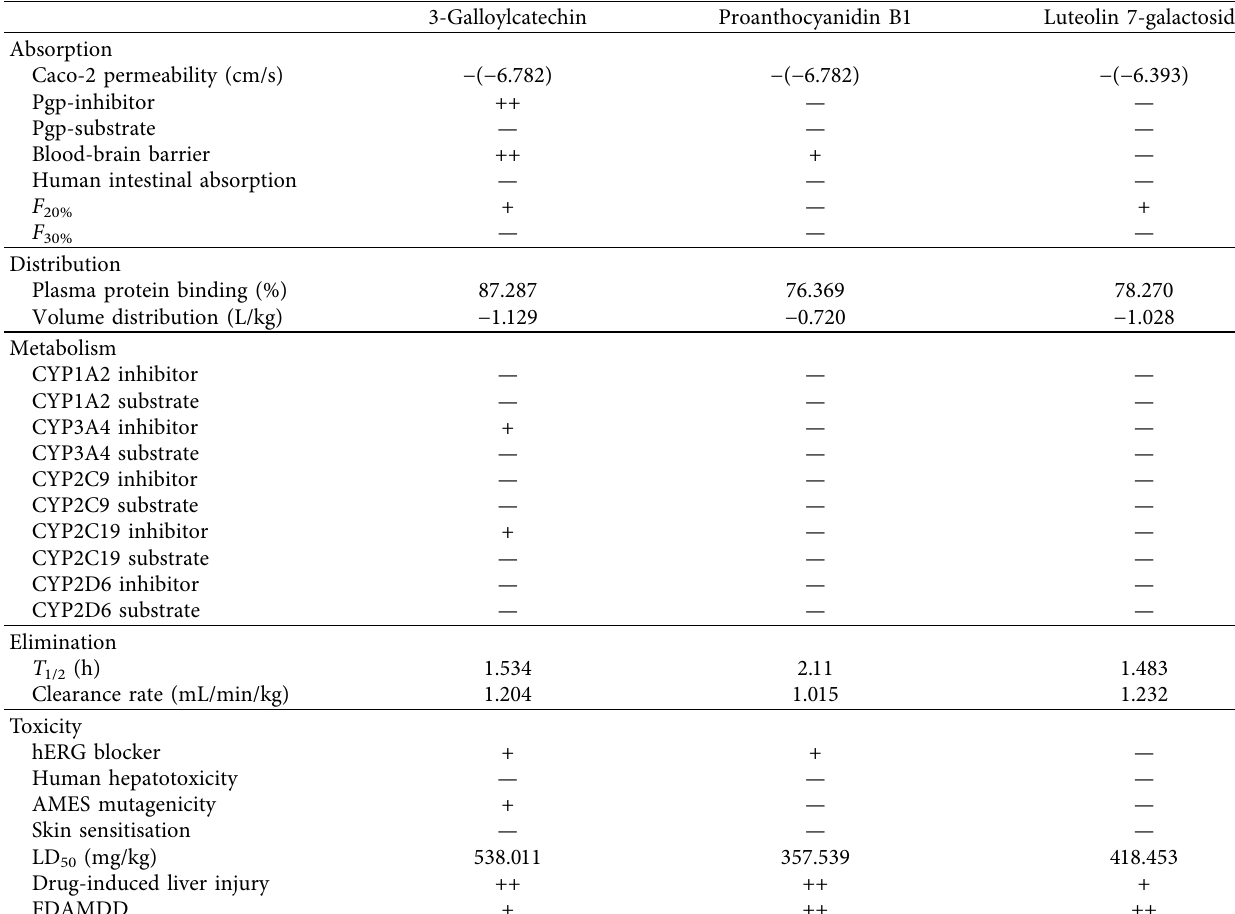
Table 4: Predicted ADMET properties of potential SARS-CoV-2 multitarget hit